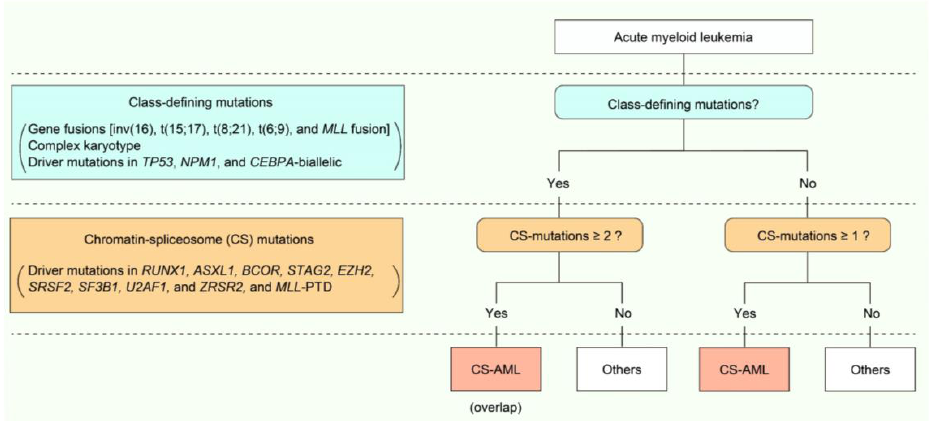
Figure 1. Definition and genetic features of chromatin-spliceosome acute myeloid leukemia (CS-AML). Scheme demonstrating the definition of CS-AML.